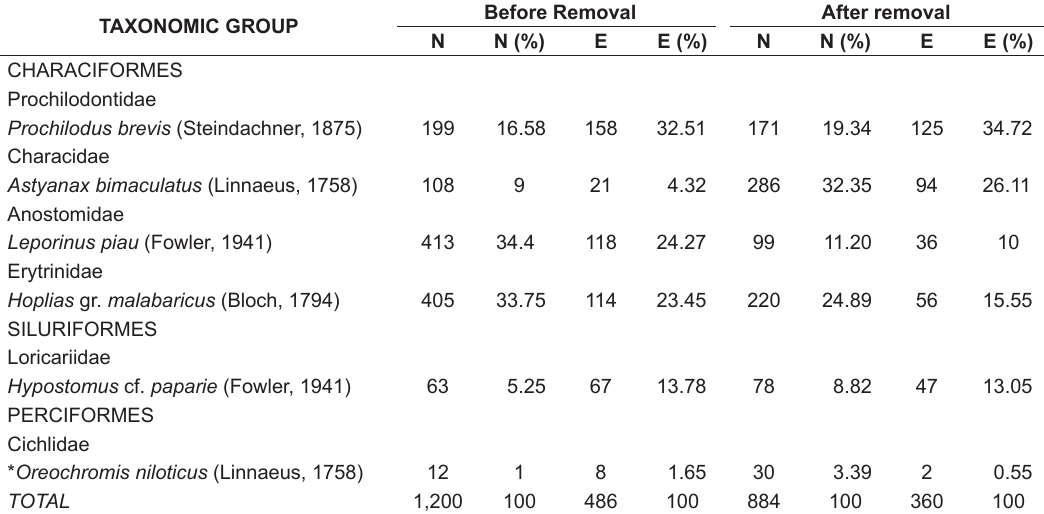
Table 1. Species of fish studied at the Estação Ecológica do Seridó (ESEC-Seridó), Serra Negra, Rio Grande do Norte, Brazil, before and after